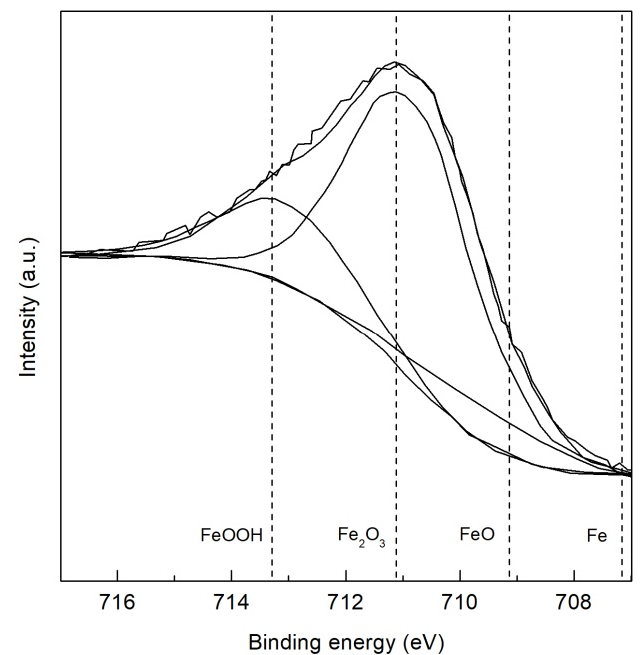
Figure 6. High resolution XPS spectra for Fe 2p 3 / 2 of TMP TWIP steel.